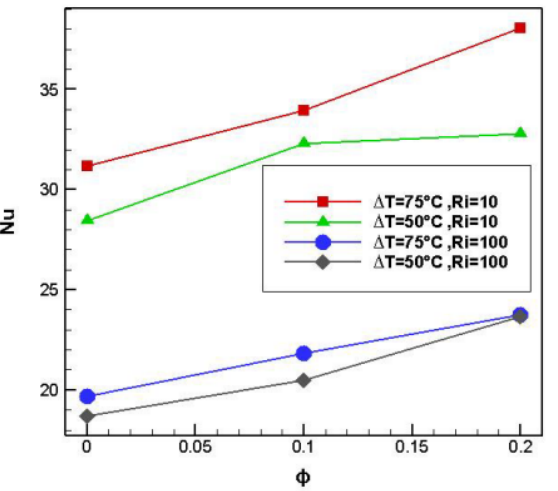
Figure 11. Nu versus φ in different ∆ T and Ri. Reprinted with permission from Ref. [28]. 2019, Elsevier.